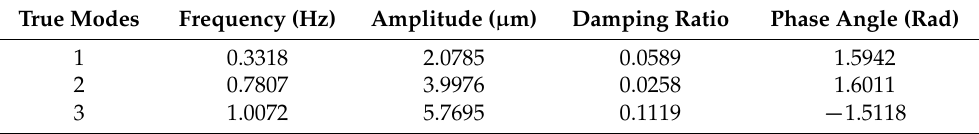
Table 4. Modal parameters matching results of signal